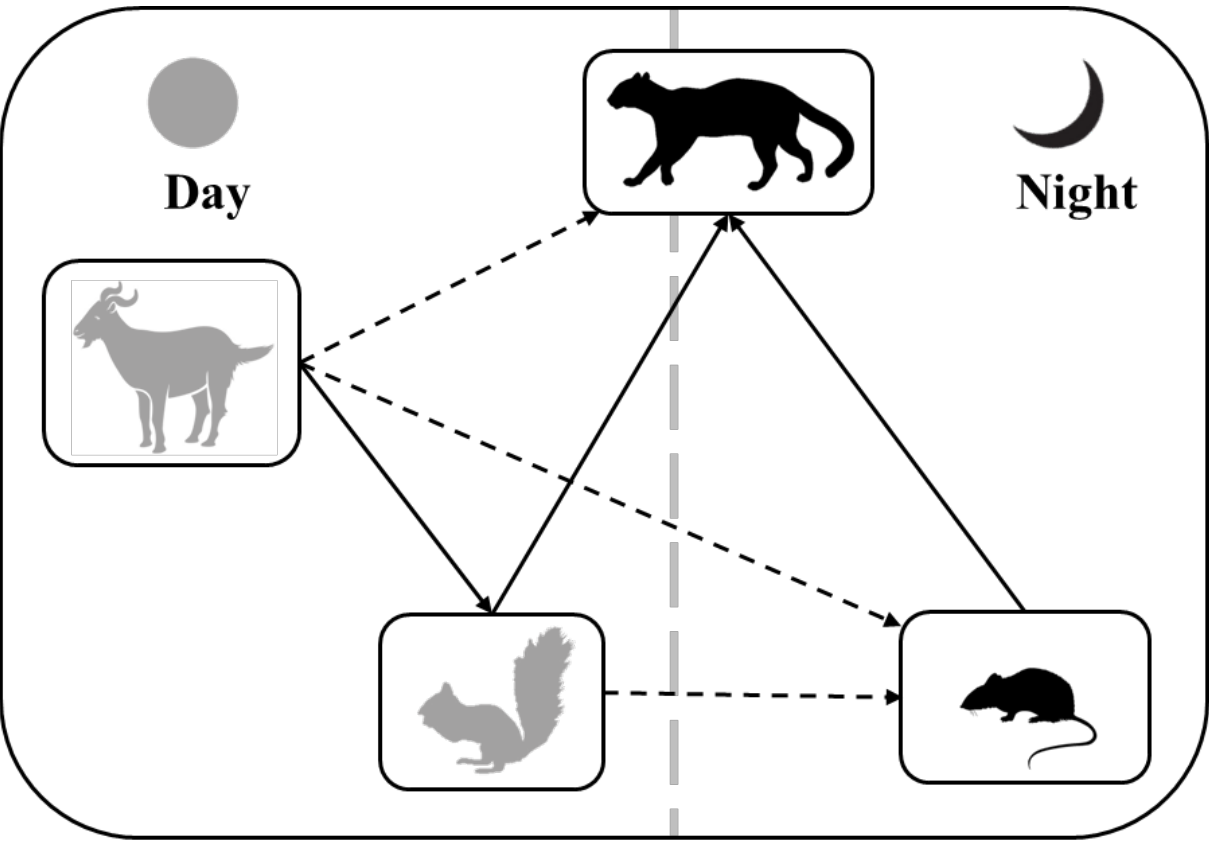
Figure 1. Conceptual model of the hypothesized interactions (e.g., site-use) between leopard cats and their prey with diurnal and nocturnal activity under livestock disturbance. Dashed arrows indicate negative effects, and solid arrows positive effects.